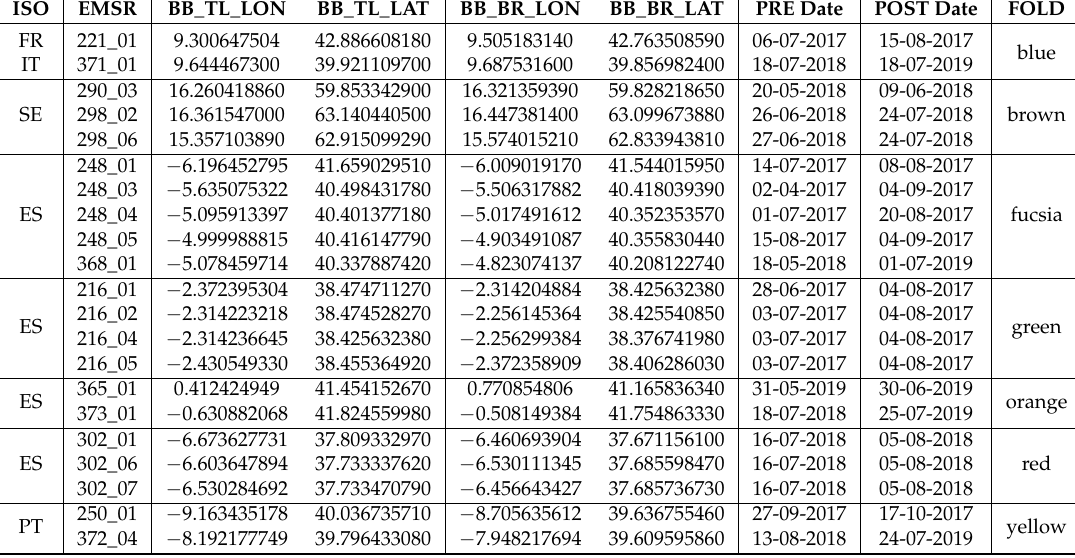
Table A1. Areas of Interest (AoIs) considered in this work. Each AoI reports information about the Country (ISO code), the grading map identifier for Copernicus EMS (EMSR), the coordinates of the AoI’s top-left and bottom-right corners, the Pre-fire (PRE Date) and Post-fire (POST Date) Sentinel-2 acquisition dates, and the related